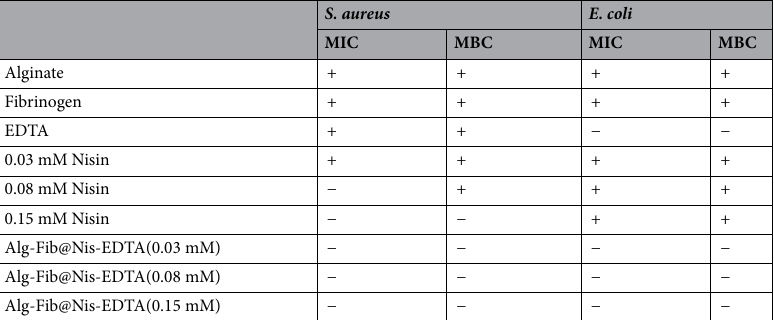
Table 2. Minimum inhibitory and bactericidal concentrations (MIC and MBC) (mM) of alginate, fibrinogen, EDTA, nisin, and the prepared hydrogel against gram-positive Staphylococcus aureus (ATCC 25923) and gram- negative Escherichia coli (ATCC 25922). Inhibitory or lethal effect: −; No inhibitory or lethal effect: +.